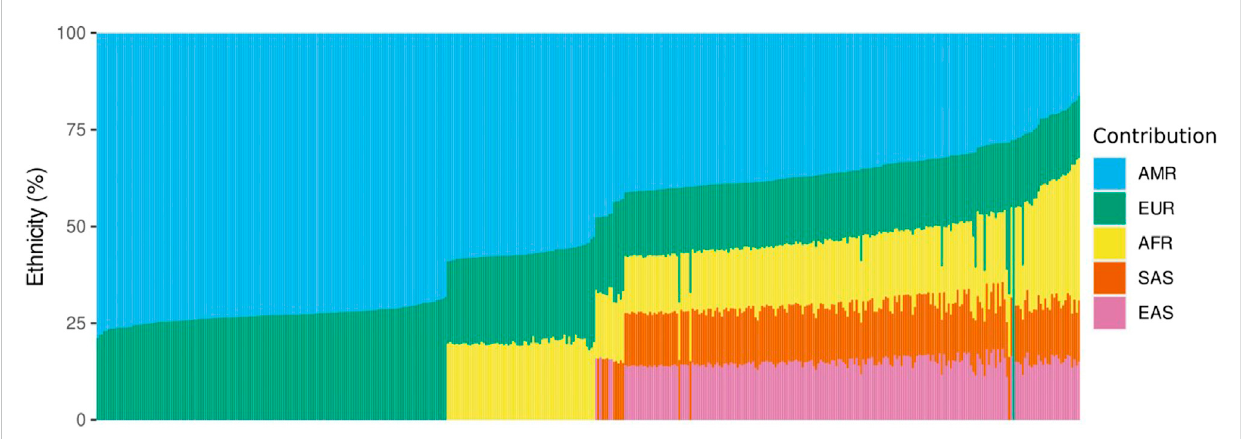
FIGURE 1 Ethnicity analysis using whole exome sequencing data. The vertical axis represents the percentage of contribution for each ethnicity, and the horizontal axis represents the individuals analyzed. AMR, American; EUR, European; AFR, African; SAS, South Asian; EAS, East